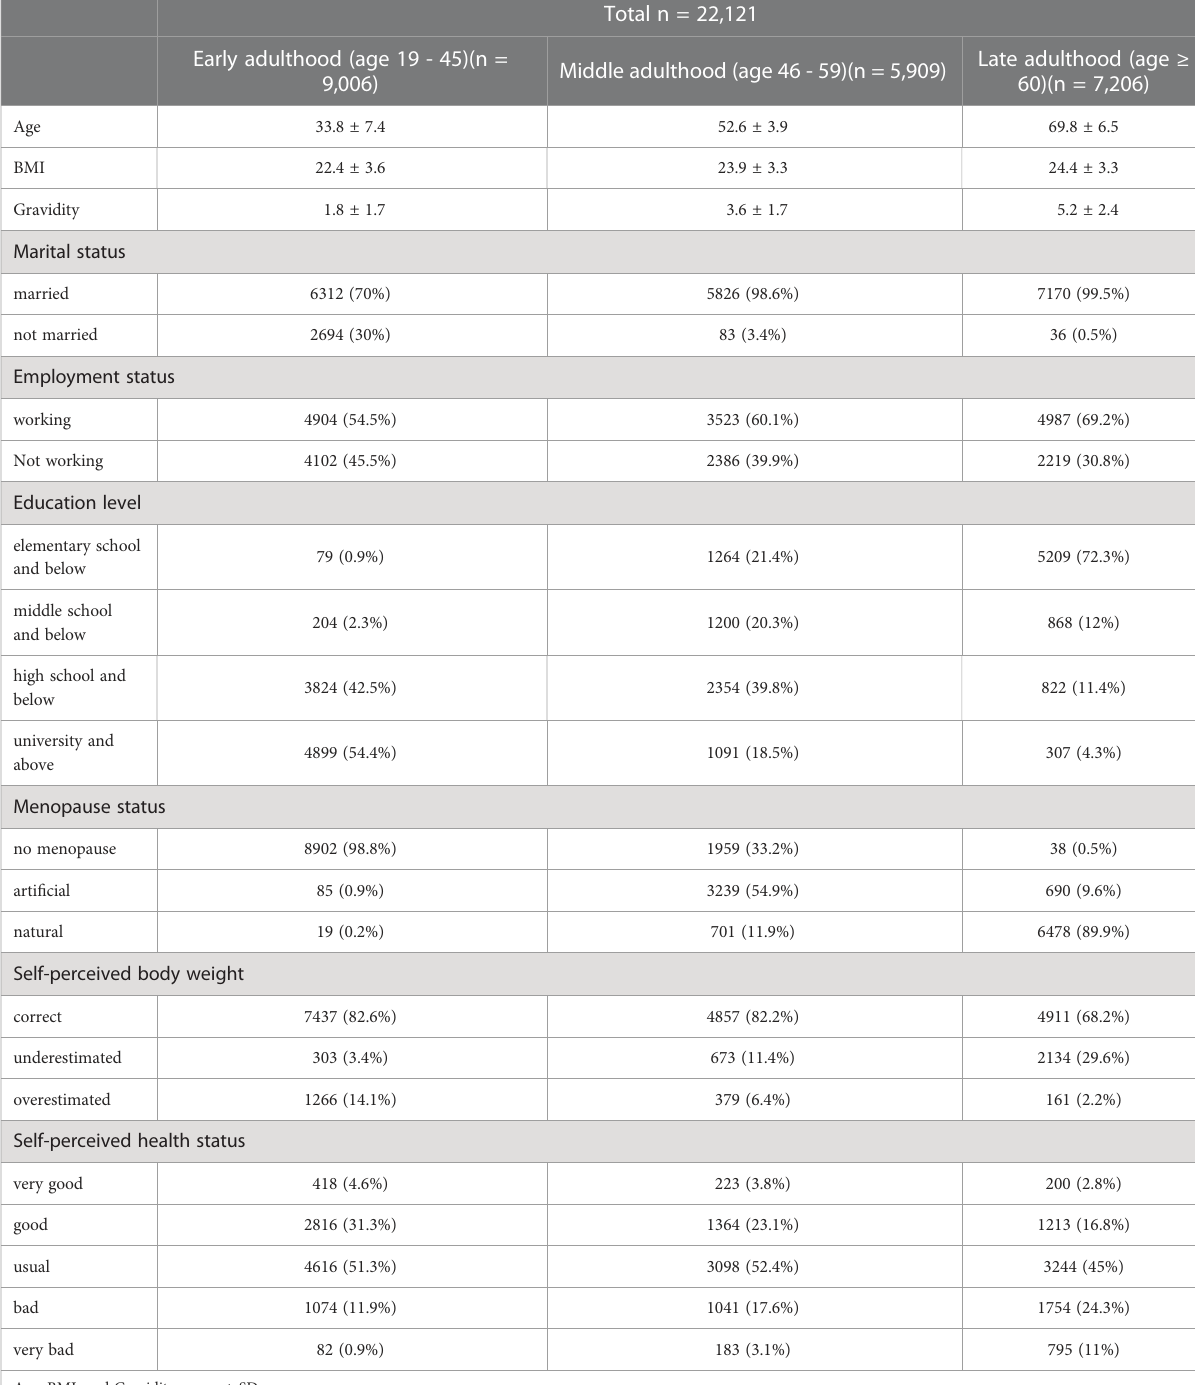
TABLE 1 Demographic characteristics of the study